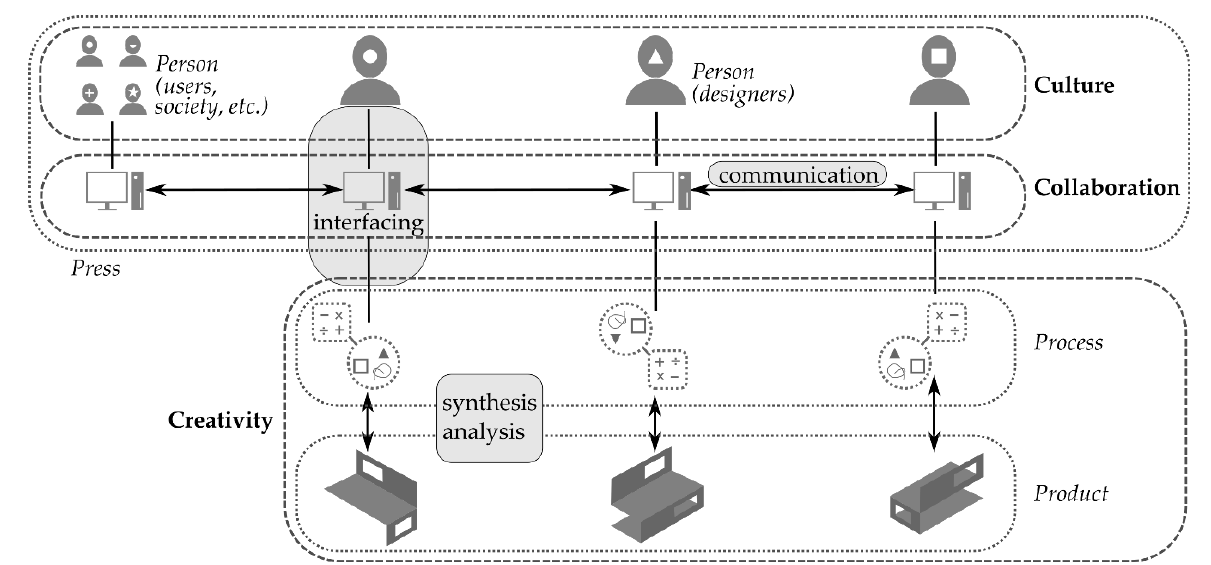
Figure 2. The relationships between the Four Ps (person, process, product and press), the Three Cs (creativity, culture and collaboration) and the four design activities (synthesis, analysis, interfacing and communication) in facilitating computational